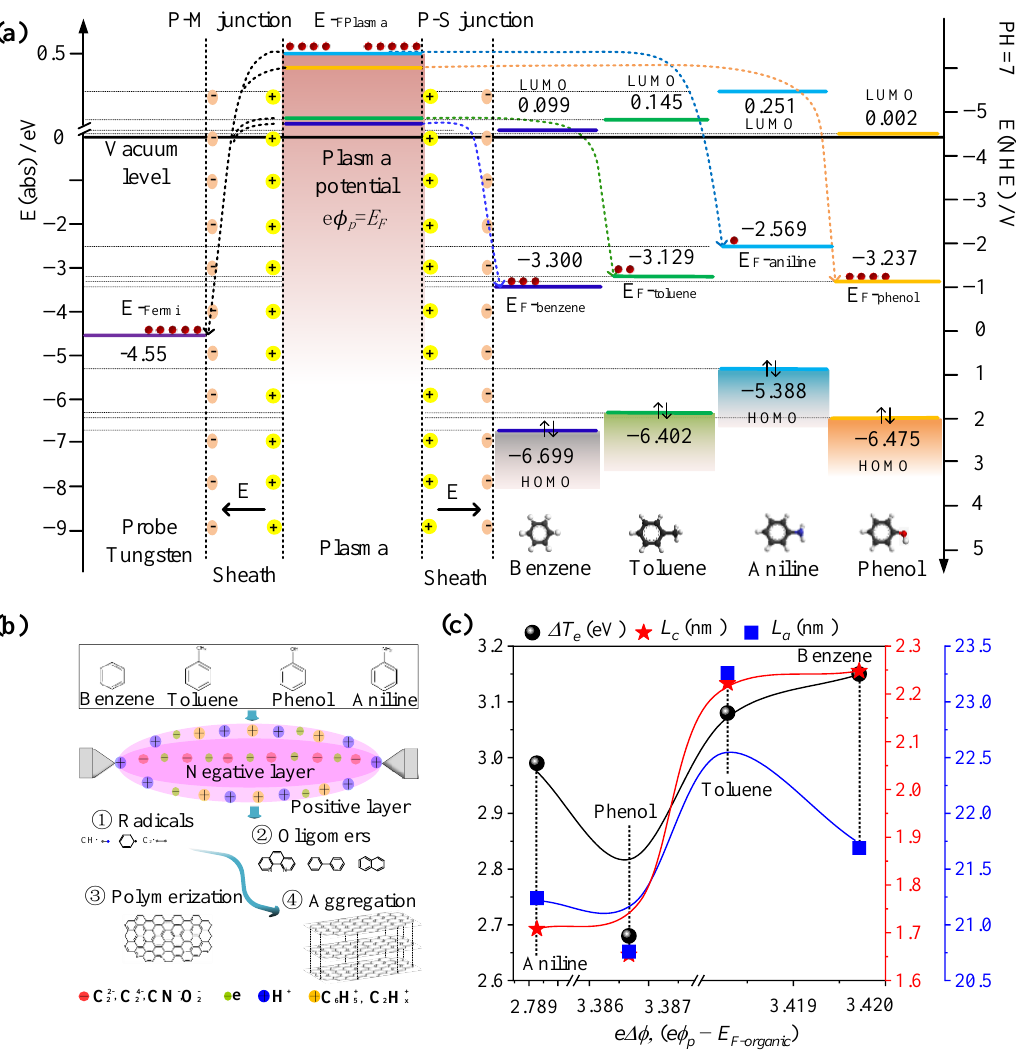
Figure 5. ( a ) Energy diagram based on equating the plasma to a semiconductor containing the Fermi energy level of the metal probe (−4.55 eV), the plasma potential , i.e., its Fermi energy level ( ϕ p ), and the HOMO (i.e., ionization potential) and LUMO (electron affinity) parameters of benzene, toluene, phenol, and aniline molecules. ( b ) Relationship of the potential difference ∆ ϕ (the difference value of the plasma potential ϕ p and E F-organic of each organic solution) with temperature gradient ∆ T e of plasma phase and gas–liquid phase, edge crystallite size L c from XRD, and in-plane crystallite size L a from Raman. ( c ) Proposed schematic mechanism of growth and formation of carbon products from benzene, toluene, phenol, and aniline.